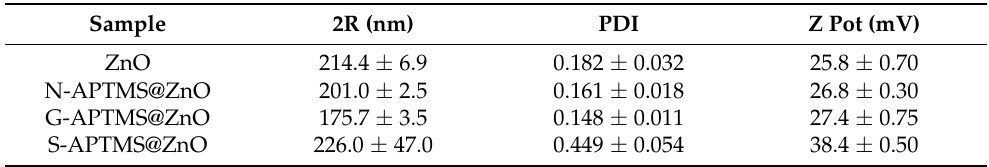
Table 4. DLS and zeta-potential measurements. 2R = Average hydrodynamic diameter; PDI = Poly- dispersity index.